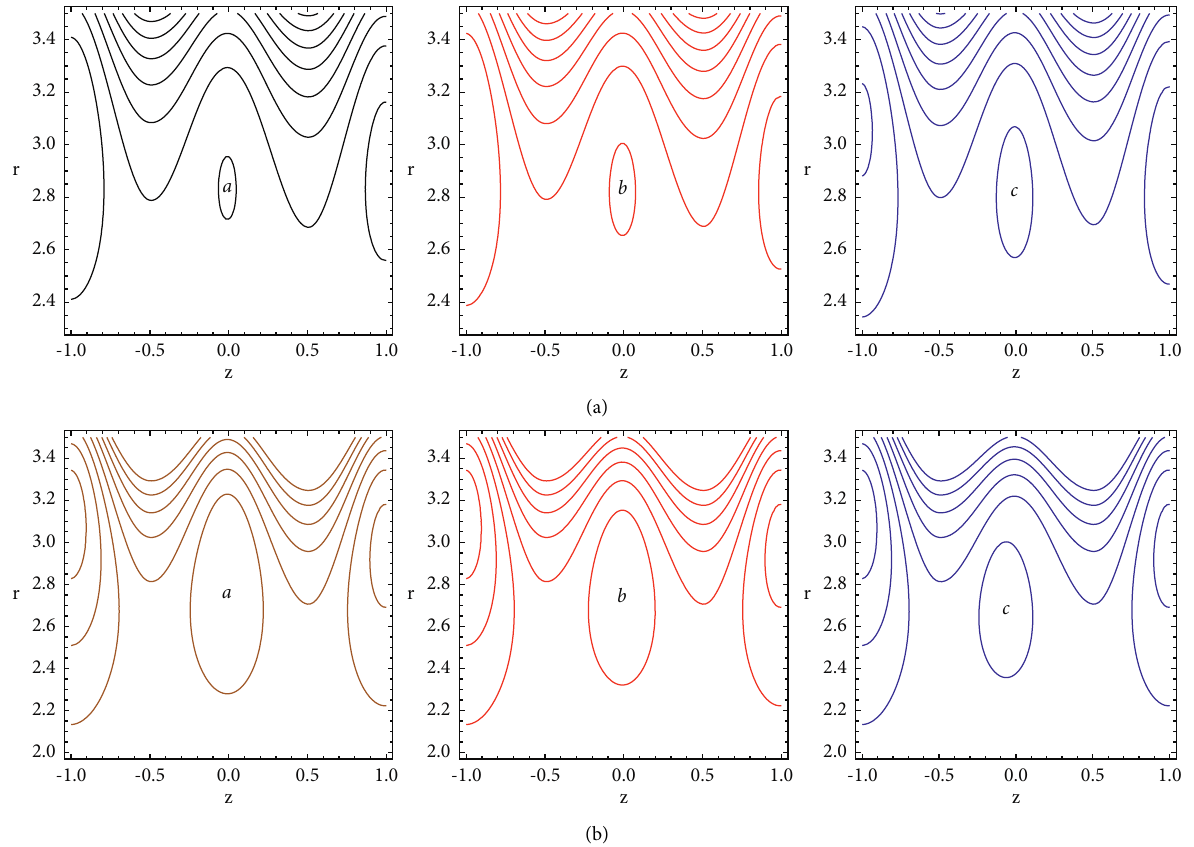
Figure 8: The streamlines’ contour plot for different values of h and m